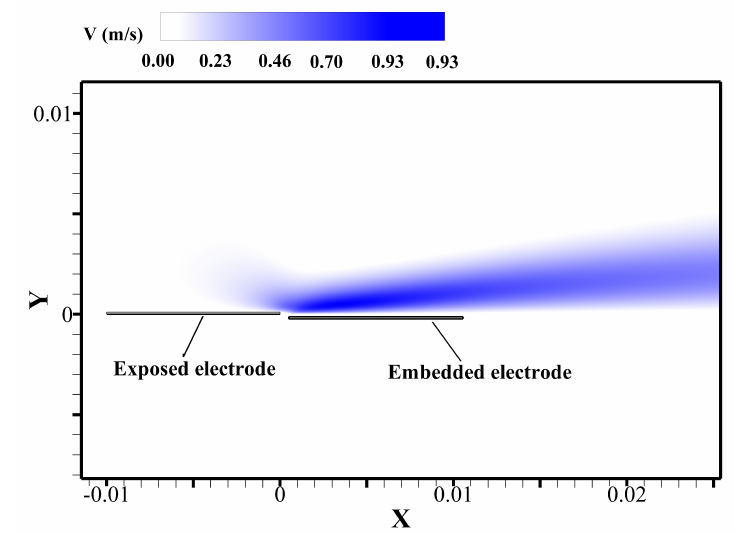
Figure 10. Velocity distribution of an SDBD actuator at zero freestream velocity. Table 4. The maximum velocity and body force magnitude generated by an SDBD actuator at